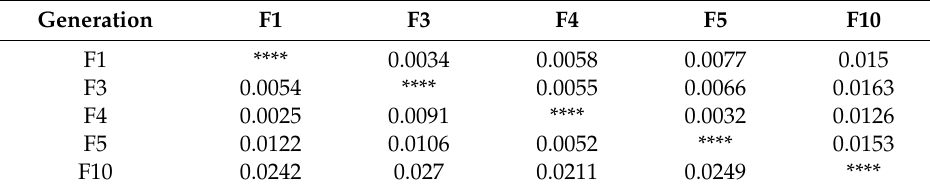
Table 4. Matrix of F ST and genetic distance among